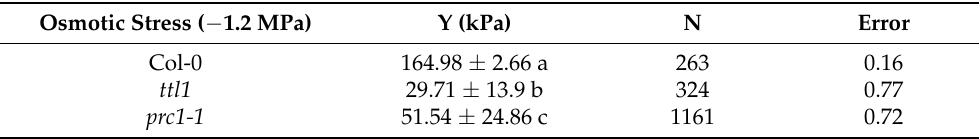
Table 2. Cell walls apparent elastic modulus measured in cells of the elongation zone of roots of Col-0, ttl1, prc1-1 and ttl1prc1-1 grown in osmotic stress conditions ( − 1.2 MPa). Osmotic Stress ( − 1.2 MPa) Y (kPa) N Error Col-0 164.98 ± 2.66 a 263 0.16 ttl1 29.71 ± 13.9 b 324 0.77 prc1-1 51.54 ± 24.86 c 1161